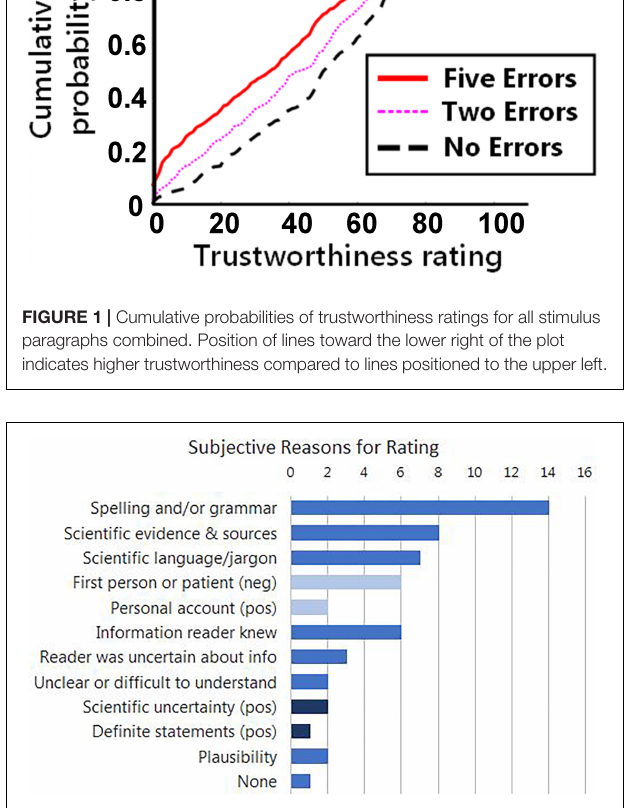
FIGURE 2 | Subjective reasons given for making their ratings. In some cases different participants provided opposing rationales for their judgments (shown in dark and light blue); for example, six participants were negatively influenced by text excerpts that were apparently written by a patient or in the first person, whereas two participants were positively influenced by personal accounts.